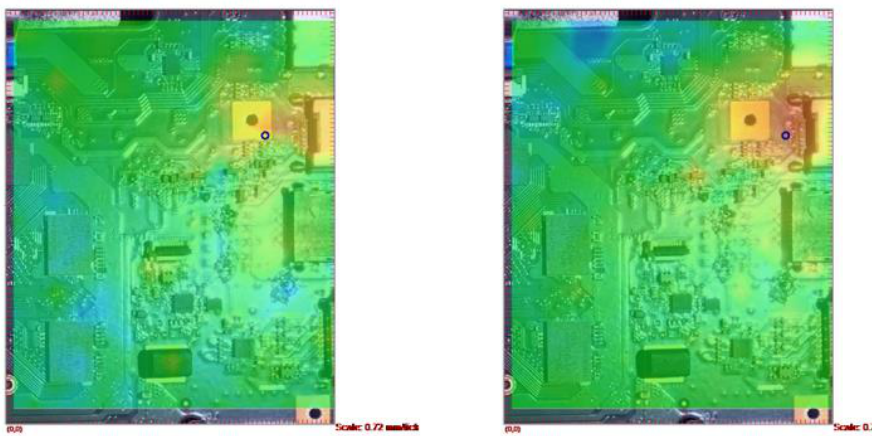
Figure 18. Intensity distribution of the near field after HDMI layout improvement . Table 1. EMI measurement data of PCB first edition.